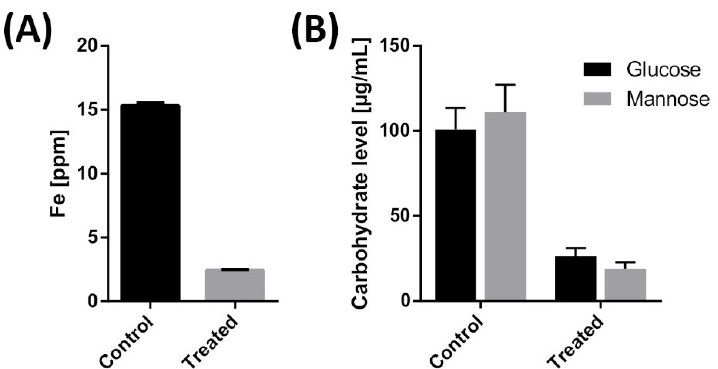
Figure 7. ( A ) Chelation activity of 20% ABIL T Quat 60 in ferric chloride solution measured by ICP-OES. ( B ) Reduction of carbohydrate level in the presence with 20% ABIL T Quat 60 measured by QTOF-LC/MS. Note that the initial concentration of ferric ion and both sugars decreased to values below the LoD in the treated samples (see Tables S1 and S2 in supplementary materials).